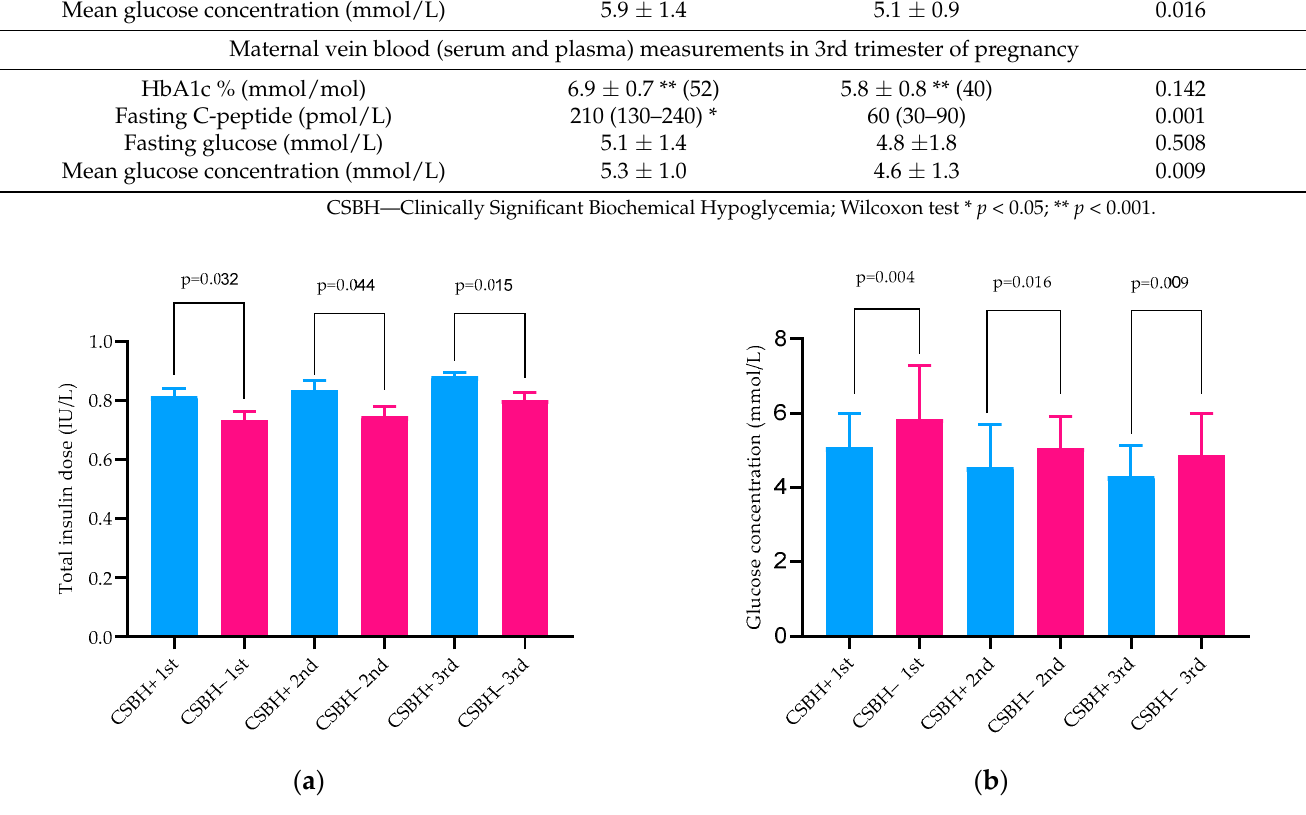
Figure 1. ( a ) Mean and standard deviation total insulin dose in two study groups in three trimesters of pregnancy (IU/kg). ( b ) Mean and standard deviation of glucose concentration in capillary plasma study groups in three trimesters of pregnancy (mmol/L). The newborns did not differ in gestational age, birth weight and length, Apgar index at 1 and 5 min, or macrosomia prevalence. No difference was found in the glucose, C-peptide concentration, and insulin resistance HOMA 2 between the study groups (Table